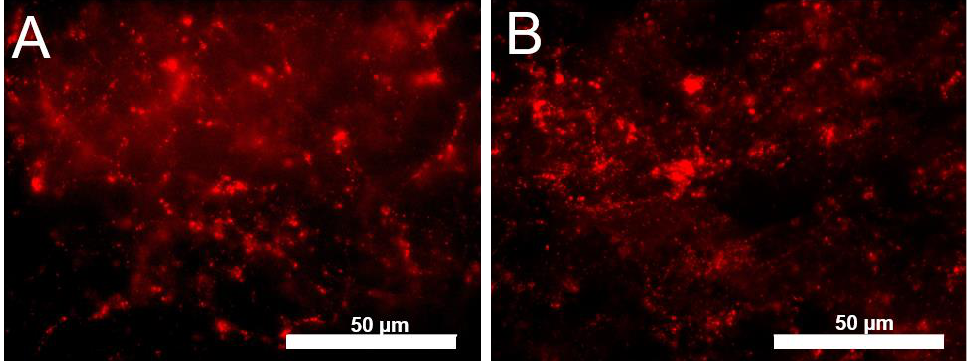
Figure 3. Avidin FND (red) containing NV centers and biotinylated fibrinogen viewed at 100× under blue excitation in formed clots. ( A ) 60 nm FND, ( B ) 120 nm FND. Scale bar 50 µ m. Ex/Em: 517/561LP.